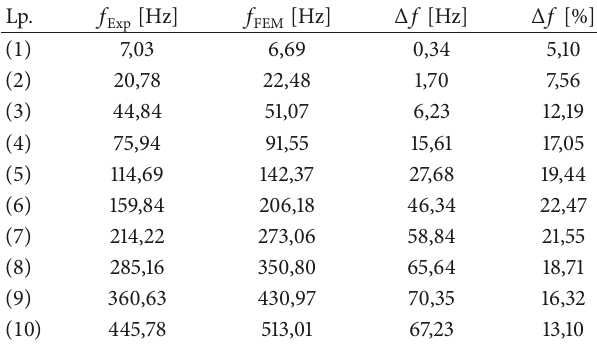
Table 1: Comparison of the first 10 natural frequency values obtained experimentally and